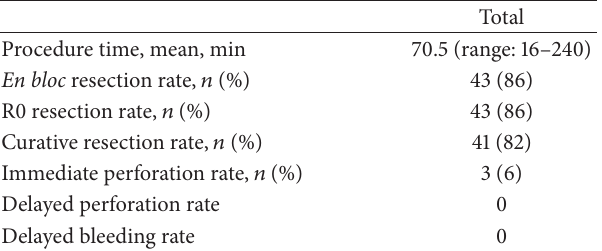
Table 2: Results of endoscopic submucosal dissection for colorec- tum.